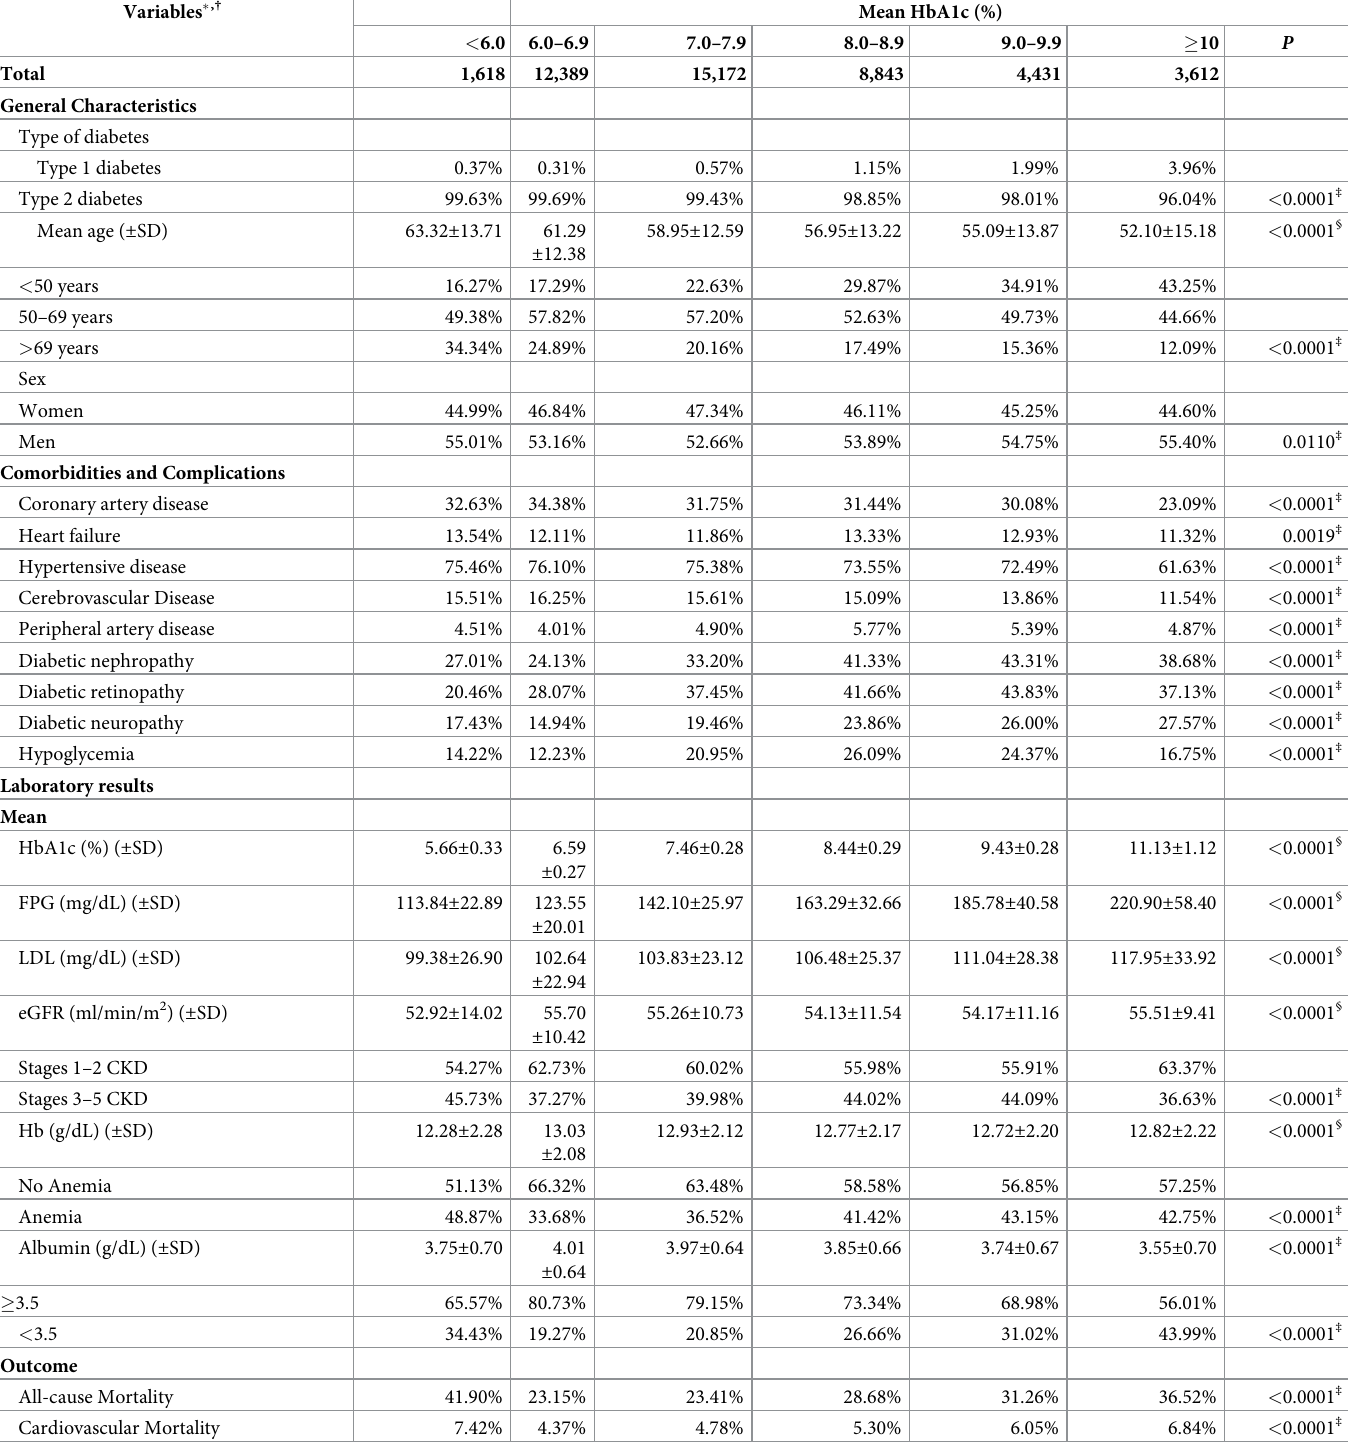
Table 1. Characteristics of the study subjects according to different mean